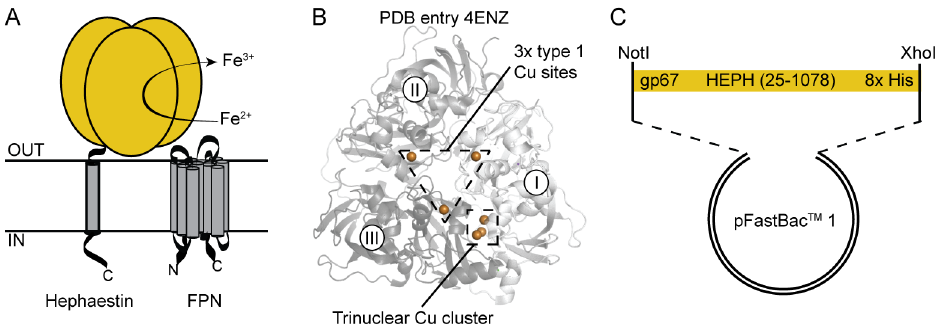
Fig 1. Hephaestin architecture and construct design. A , Schematicillustrationof HEPH function. Ferroportin(FPN) exports divalentiron into plasma, where HEPH catalyses the conversionto trivalent metal. B , The structure of ceruloplasmin shown in cartoon representation, with the three copperbindingdomains coloured in different shades of grey. Copperions are shown as orangespheres. In ceruloplasmin, 3 peripheral Type I copper sites shuttle electronsfrom the Fe 2+ —Fe 3+ oxidation,with the electrons being transferred to the trinuclear coppercluster. C , The overall construct design used in this study.